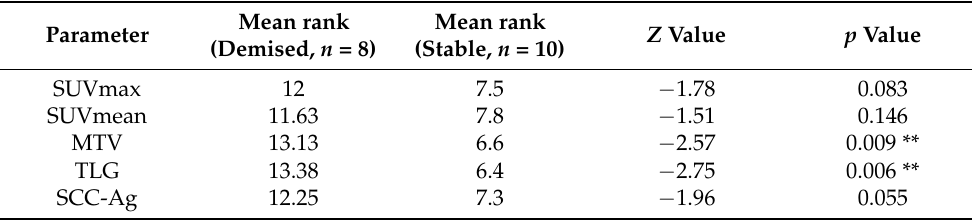
Table 3. Comparison of the tumor metabolic parameters of demised versus stable patients by Mann– Whitney U test analysis. Mean rank Mean rank Parameter (Demised, n = 8) (Stable, n = 10)